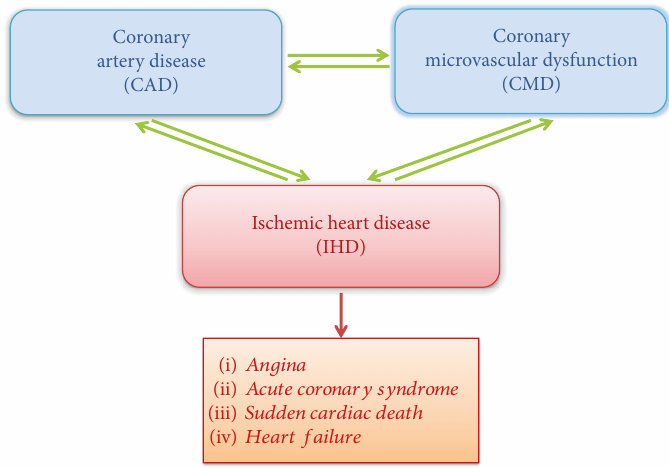
Figure 1: Pathophysiological basis of IHD and its clinical manifestations.